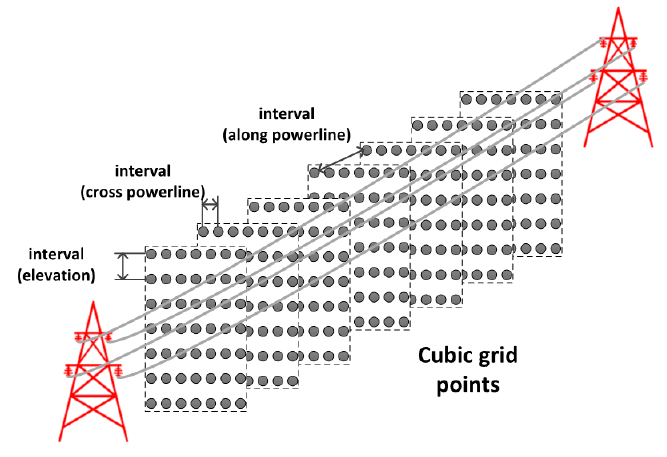
Figure 3. Generation of cubic grid points around the power lines in the object space (3D).